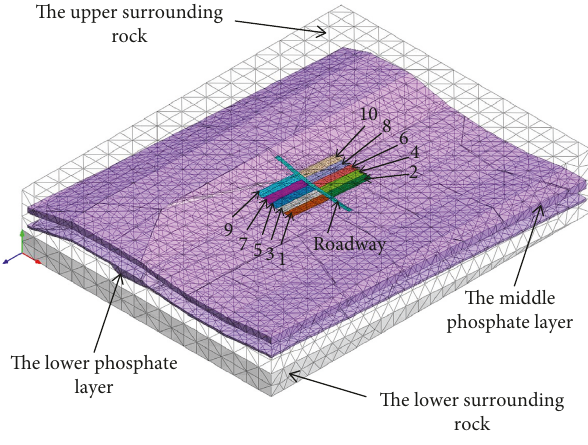
Figure 1: Model with strip width of 9m. Table 2: Simulation schemes.